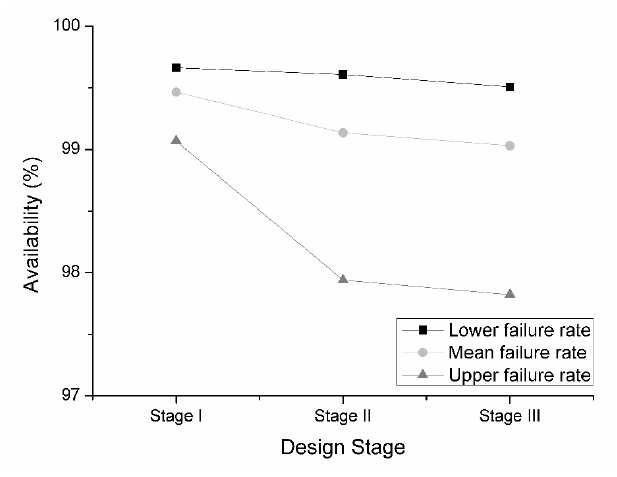
ff erent failure rate.